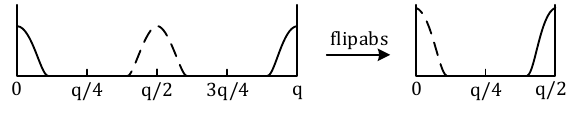
Figure 5: NewHope flipabs routine